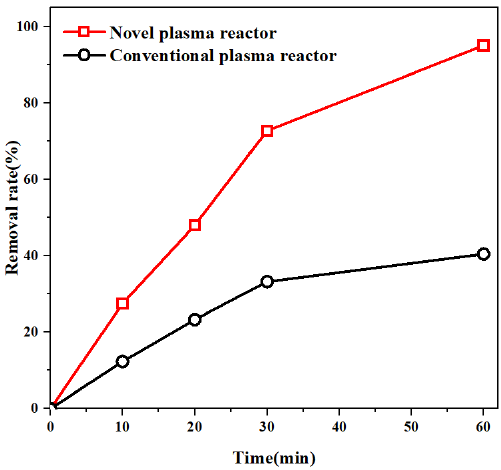
Figure 6. RSM for degradation efficiency of MO as a function of voltage and time ( a ), discharge gap and time ( b ), discharge needle numbers and time ( c ), discharge needle numbers and discharge gap ( d ), discharge gap and voltage ( e ), discharge needle numbers and voltage ( f ).